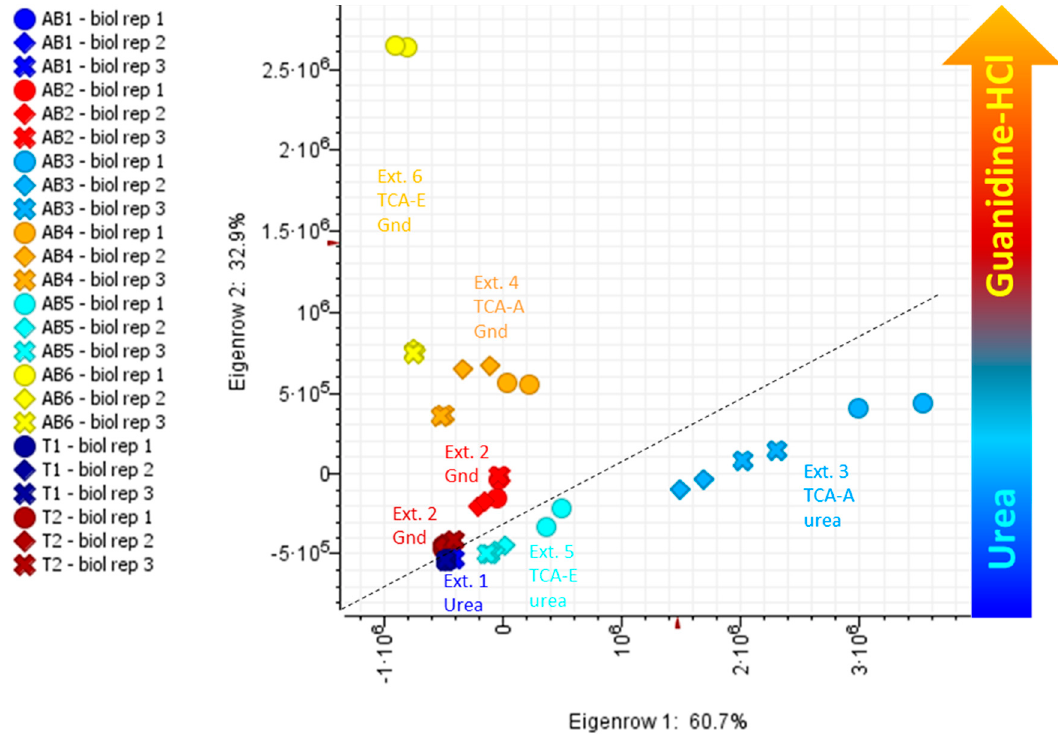
Figure 2. Principal component analysis (PCA) using intact protein data. AB, apical buds; T, trichomes; 1–6, extraction methods 1 to 6. For details on extraction methods (AB1-6 and T1-2) refer to Figure 1.